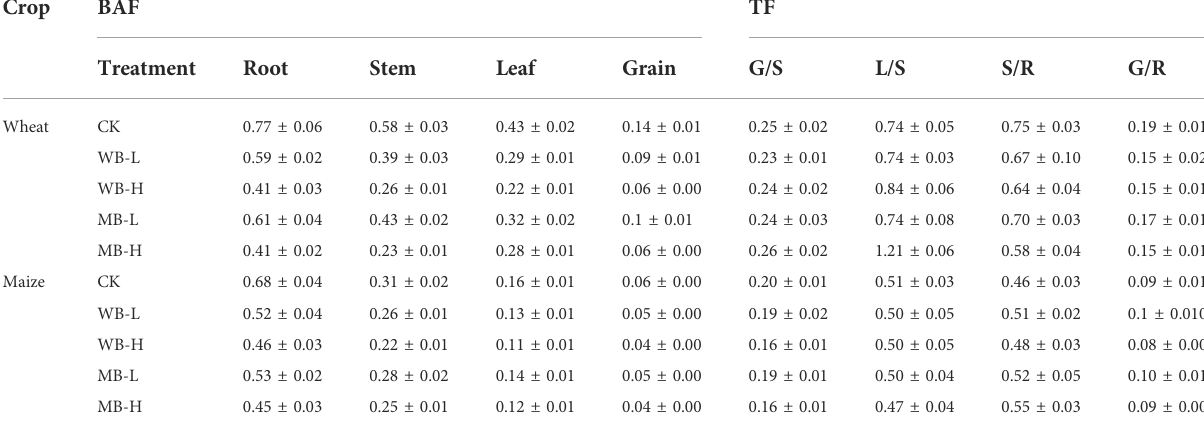
TABLE 2 Cd bioaccumulation factor (BAF) and translocation factor (TF) of wheat and maize tissues. Crop